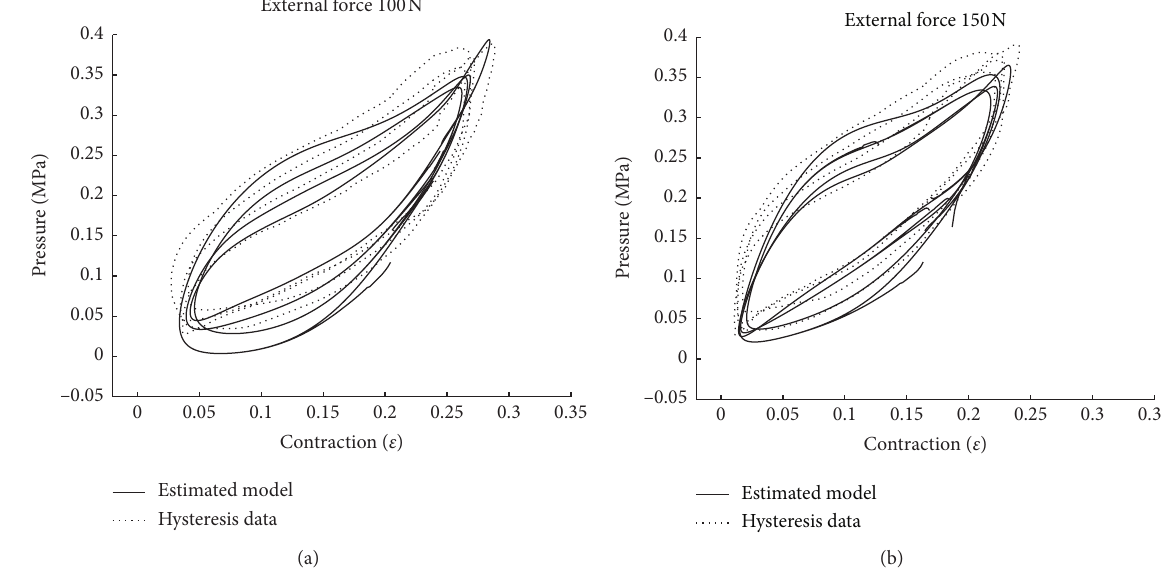
Figure 10: Shape estimation at various frequencies: (a) external force 100N and (b) external force 150N.